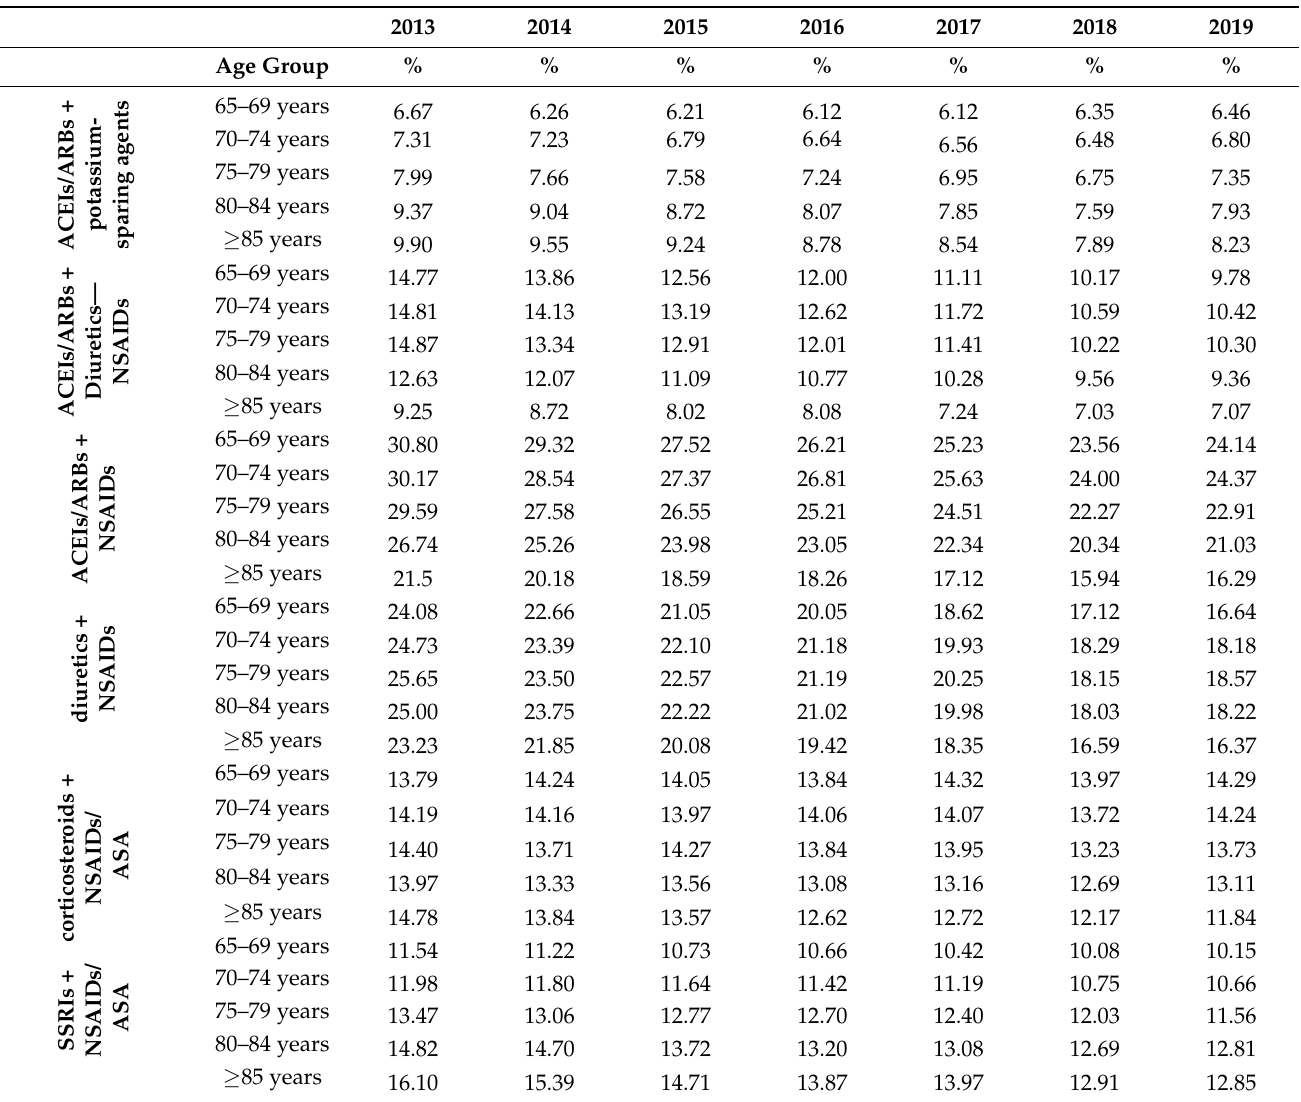
Table 3. Prevalence of DDIs involving antihypertensives and/or NSAIDs by year stratified by age classes. 2013–2019, Piedmont region